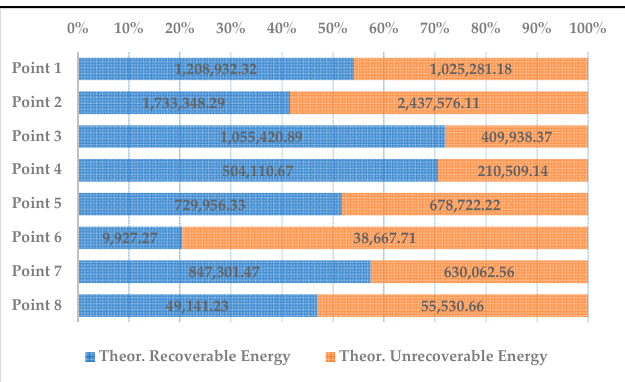
Figure 6. Energy distribution comparison for each point.